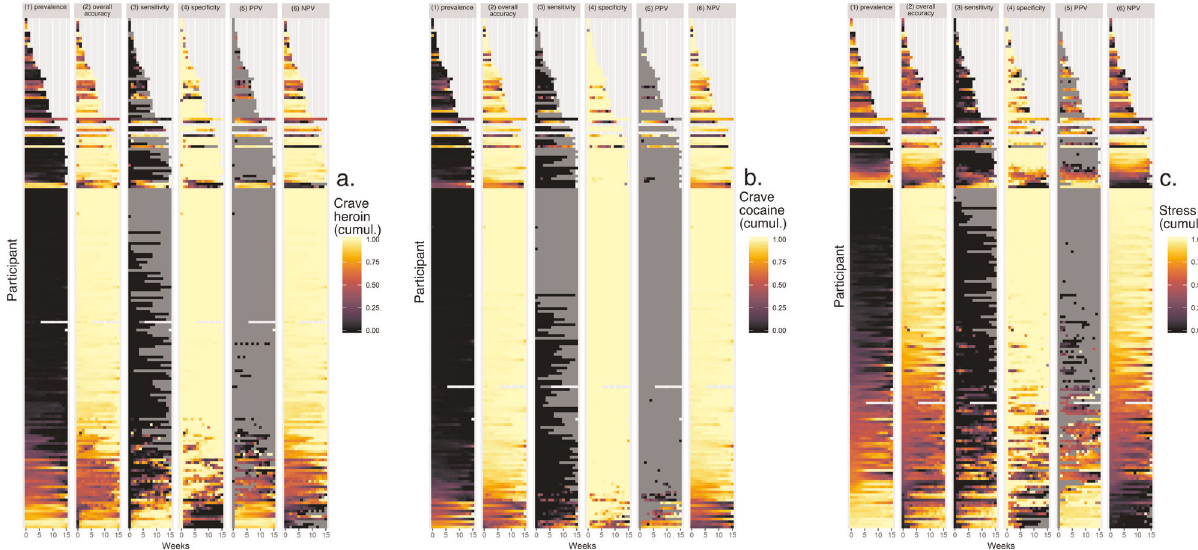
Fig. 3 Prediction accuracy (and prediction-target prevalence) per person per week, for each participant. These heat maps recapitulate prevalence (column 1) and show model accuracy per person per week (column 2, overall accuracy; 3, sensitivity; 4, speci fi city; 5, positive predictive value; 6, negative predictive value). In columns 2 – 6, the color scheme is as follows. White: missing data. Gray: accuracy not calculable due to non-occurrence of event. Purple/black: low accuracy: Orange and yellow: high